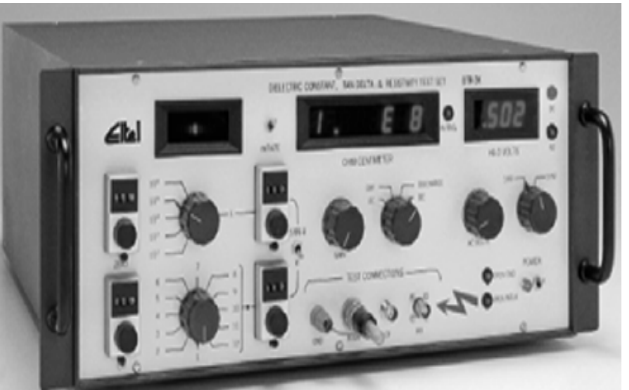
Fig. 1. Tan Delta test cell.